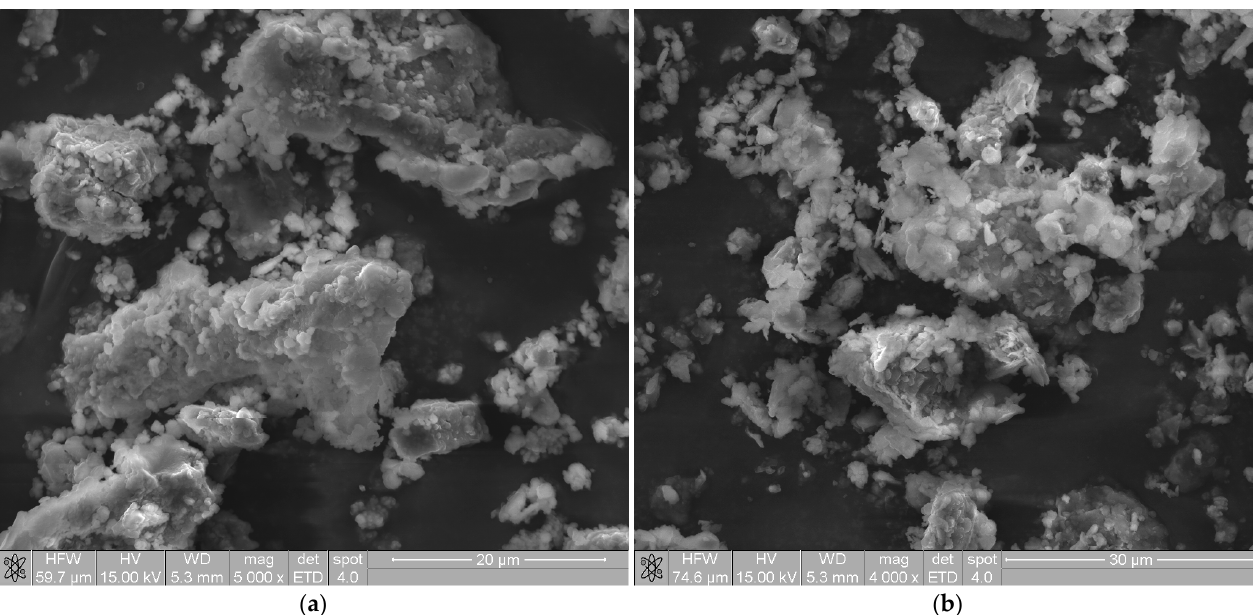
Figure 2. Grains of FBC fly ash from brown coal combustion (FBC FA BC)—( a ) × 5000 and from hard coal combustion (FBC